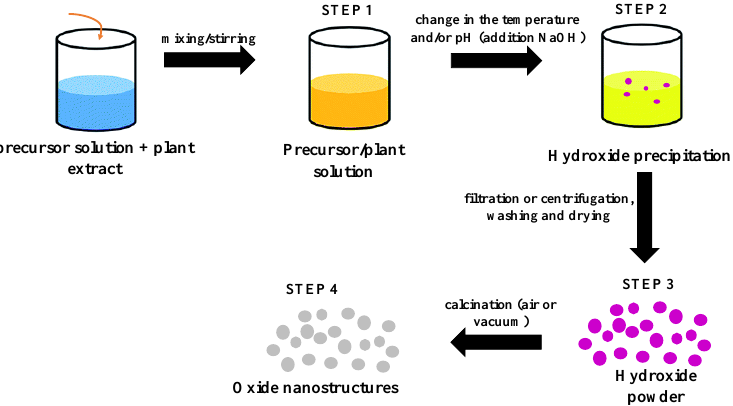
Figure 6. Schematic diagram showing all steps involved in a generic green synthesis mediated by plant extract using the co-precipitation method.